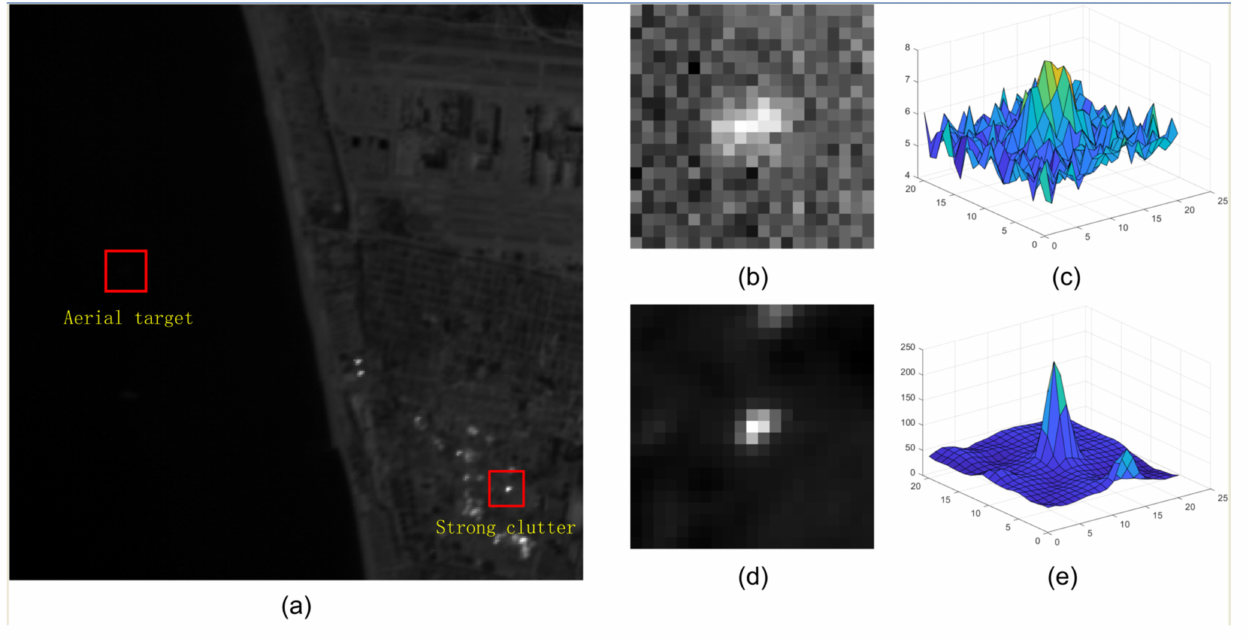
Figure 1. ( a ) The aerial target and strong clutter in the space-based IR image; their details are magnified in ( b – e ). ( b ) The local slice of an aerial target. ( c ) Three-view of the aerial target. ( d ) Local slice of strong clutter. ( e ) Three-view of strong